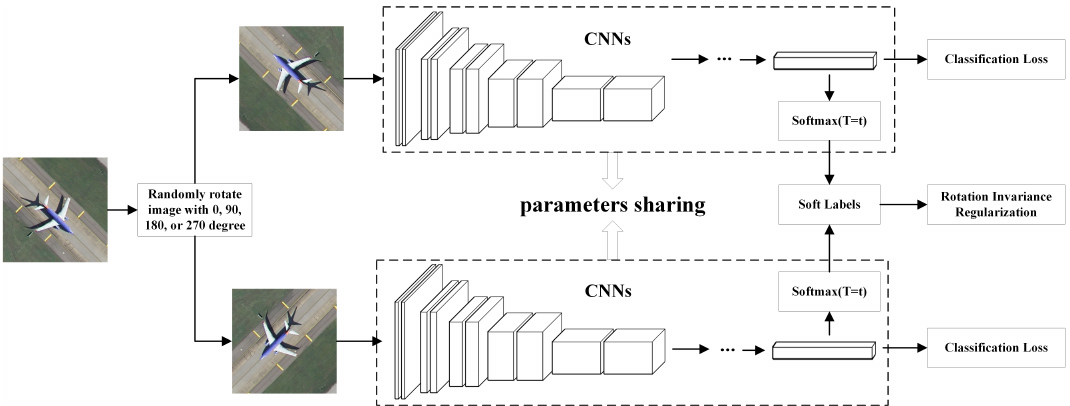
Figure 2. Architecture of the proposed network model. This network is composed of two identical convolutional neural network (CNN) models. The input image is randomly rotated by 0, 90, 180, or 270 degrees. These two CNN models takes a pair of rotated images with different rotation angles as input. The rotation invariance regularization term is imposed on the features learned through these two CNN